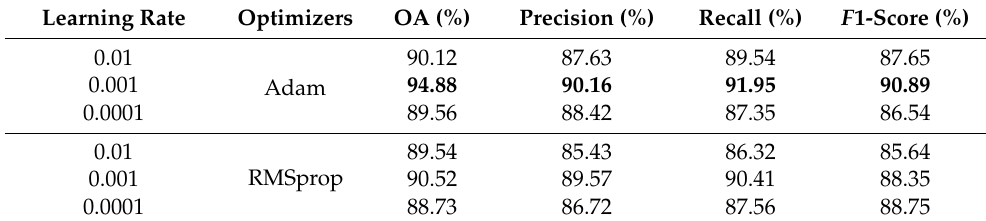
Table 8. The results for different combinations of